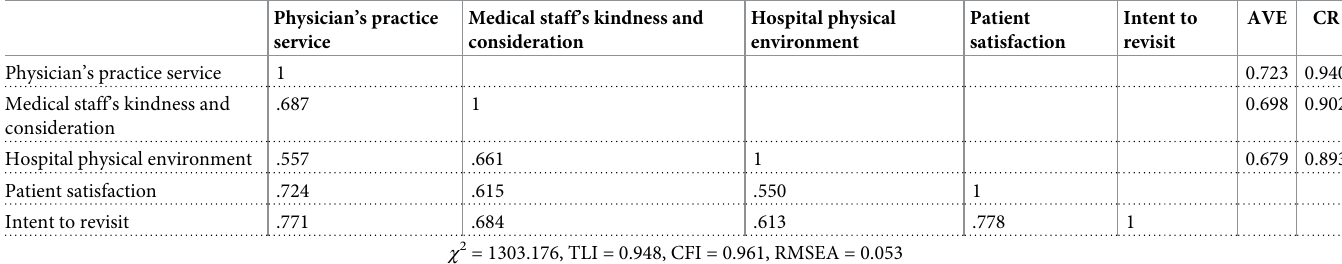
Table 2. Correlation matrix